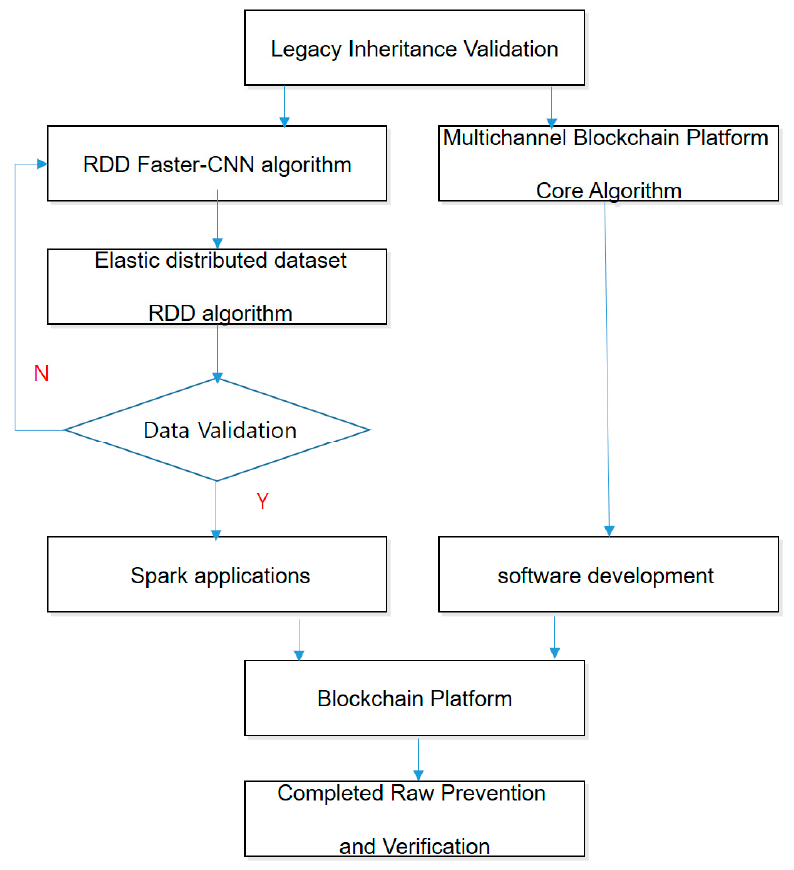
Figure 4. Legacy inheritance validation deep learning blockchain model .